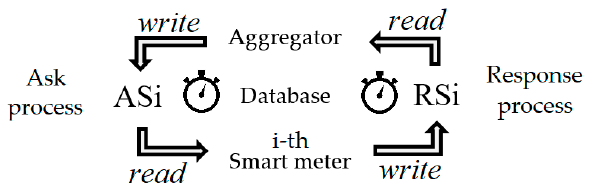
Figure 3. Communication between aggregator and smart meters, a database interfaces them.